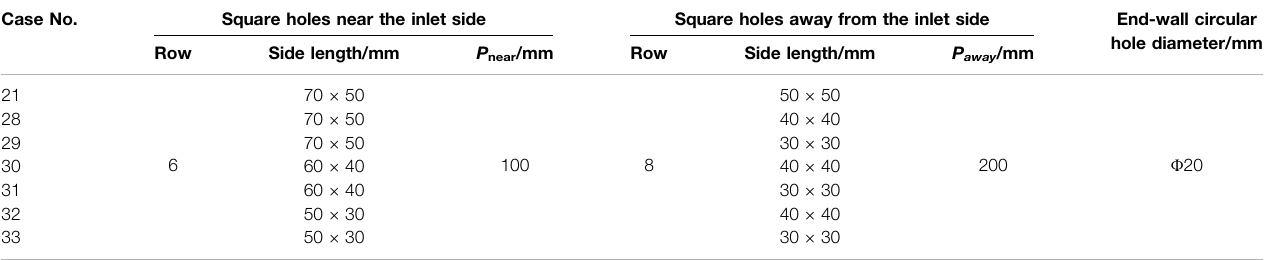
TABLE 11 | Characteristic geometrical parameters of fl ow homogenizers with different square hole sizes. Case